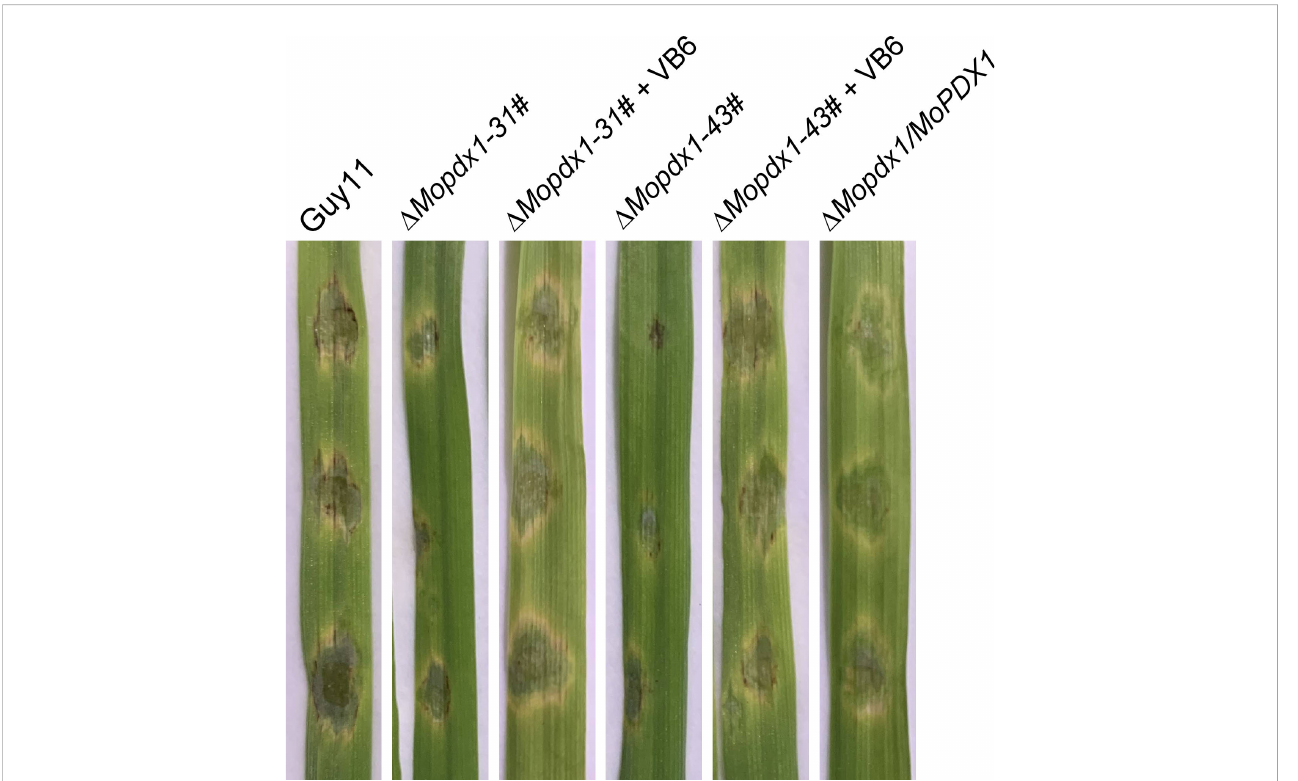
FIGURE 6 The addition of VB6 rescues the pathogenicity defect of MoPDX1 deletion mutants on barely leaves. Twenty- fi ve microliters of conidial suspensions (5×10 4 spores/mL) of Guy11, two D Mopdx1 mutants, and the complementary strains were separately inoculated on the surface of 7-d detached barely leaves, which were then inoculated at 28°C for 24 h in the dark, and for another 4 days under continuous12 h/12 h light/dark conditions. In addition, conidial suspensions of the two mutants were added 10 -4 mg/mL VB6 solution. Then, inoculated on the barely leaves under the same environmental conditions as described above. The experiments were repeated three times with similar